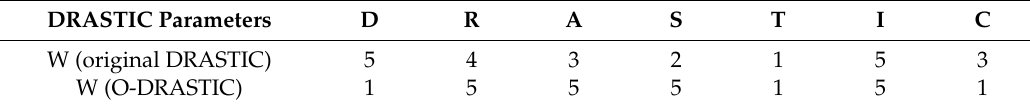
Table 4. Weights of parameters of original DRASTIC and optimum